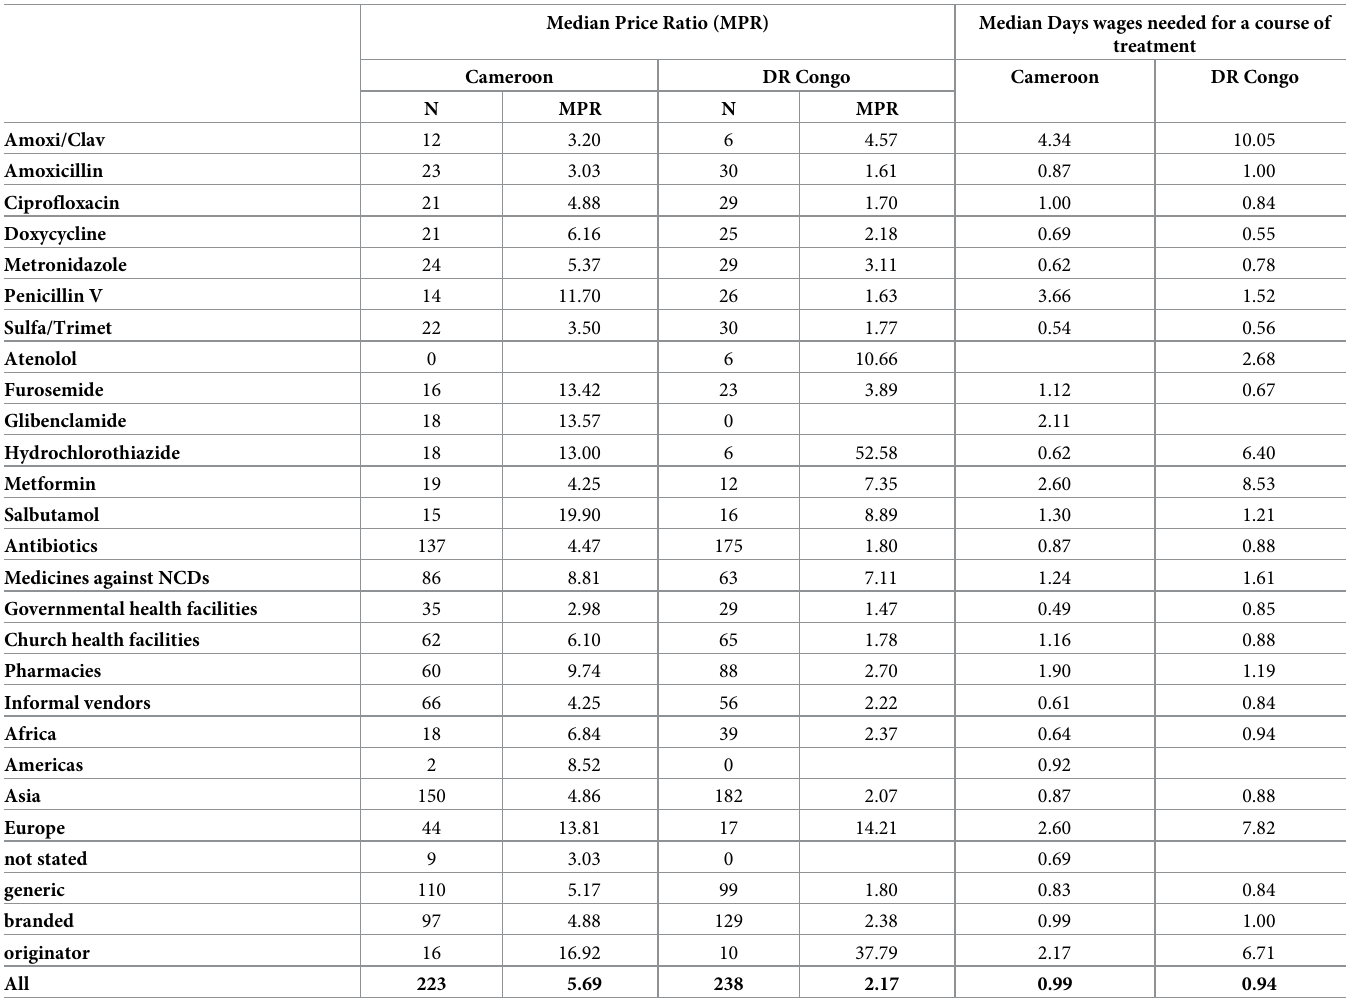
Table 3. Median price ratios for medicines and days wages’ needed for a course of treatment in Cameroon and in the DR Congo. The continent of origin of the med- icines is given as stated on the